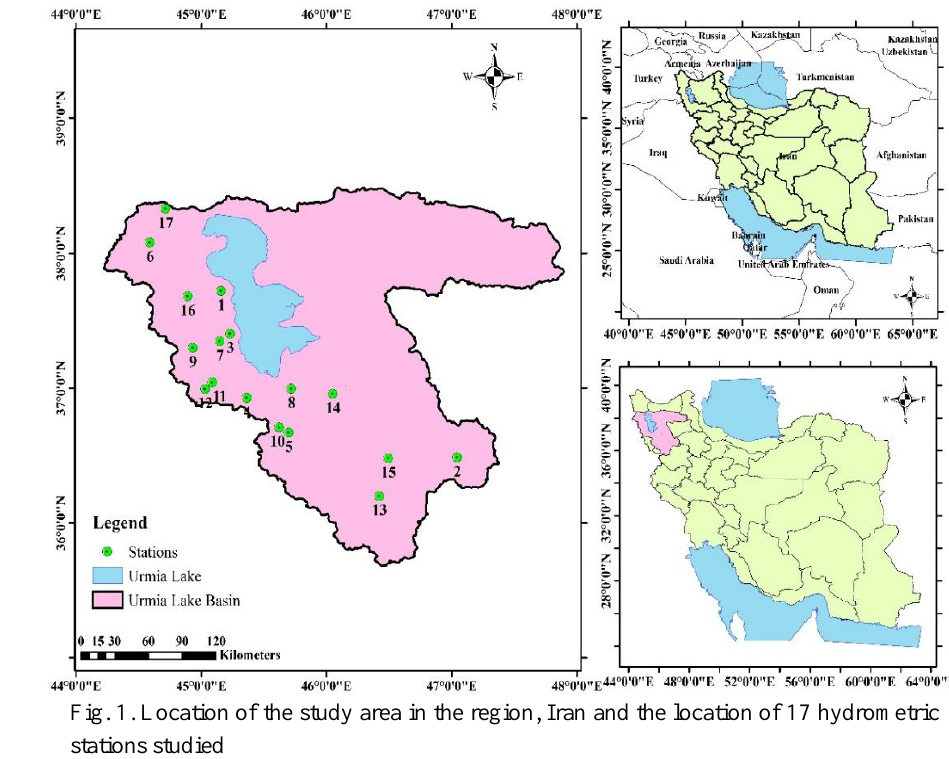
Fig. 1. Location of the study area in the region, Iran and the location of 17 hydrometric stations